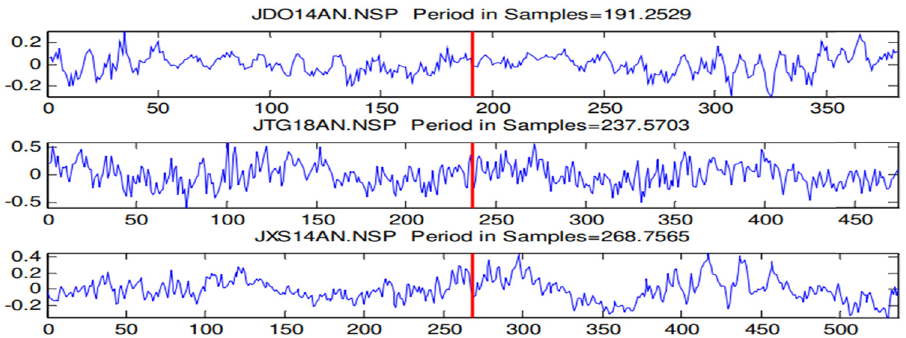
Figure 1: Three types of signal examples from the MEEI database [ 15 ]